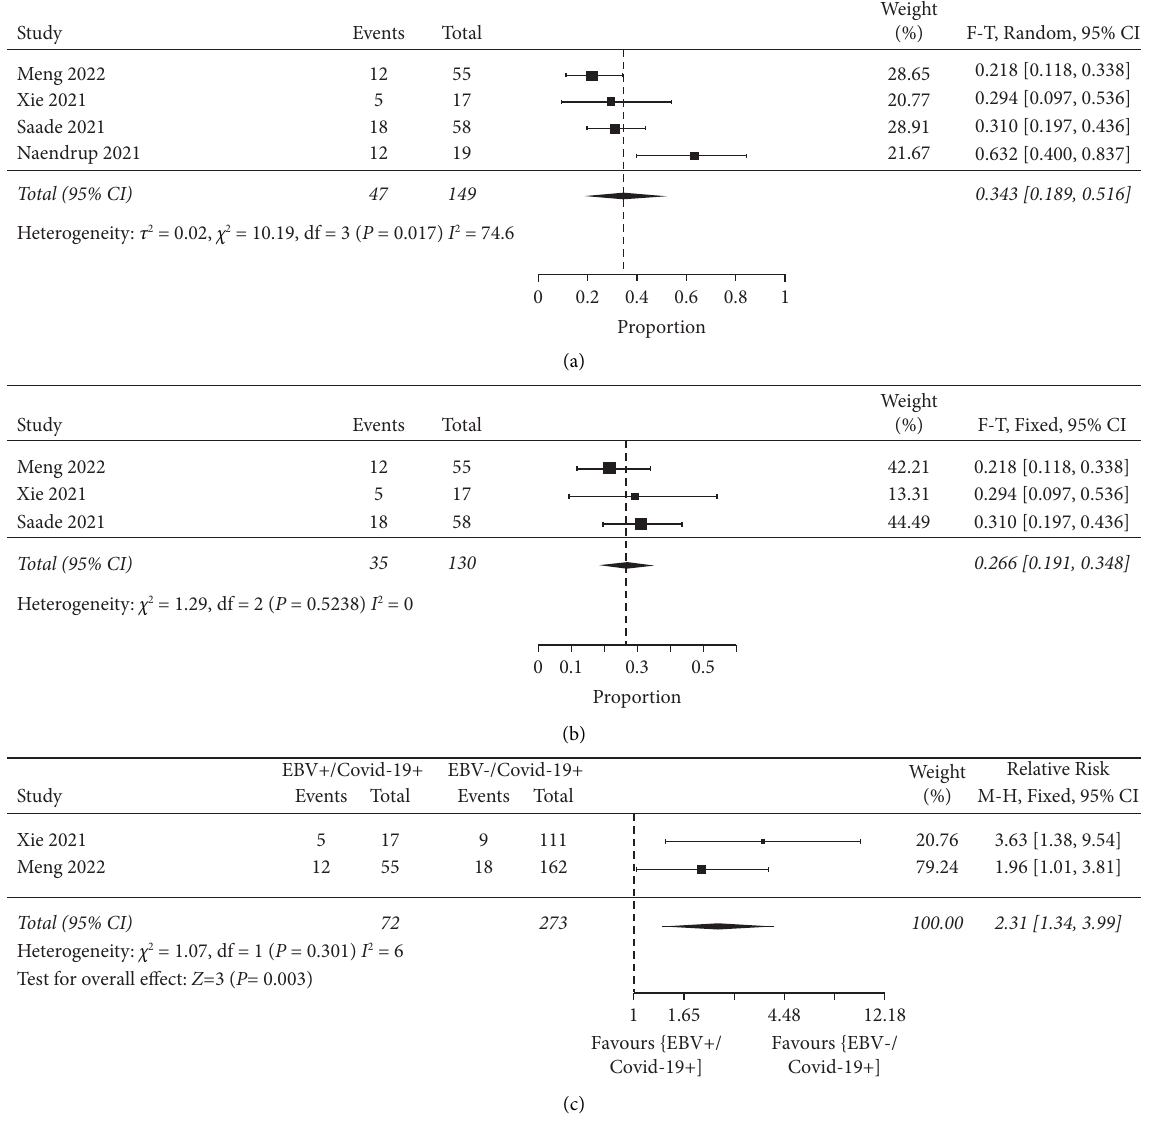
Figure 2: Forest plots of proportional and comparative MA, respectively. (a) Proportional MA using Freeman–Tukey (F–T) statistical approach to detect percentage of mortality in COVID-19 patients with reactivated EBV. Te analysis was carried out using JBI SUMARI. Te EBV reactivation data for Saade et al. [14] was extracted from the database provided by the authors. (b) Subgroup analysis to address high heterogeneity found in Figure 2(a). (c) Comparative meta-analysis using dichotomous data type, relative risk, confdence interval (CI), and Mantel–Haenszel (M–H) statistical method in COVID-19 patients with and without